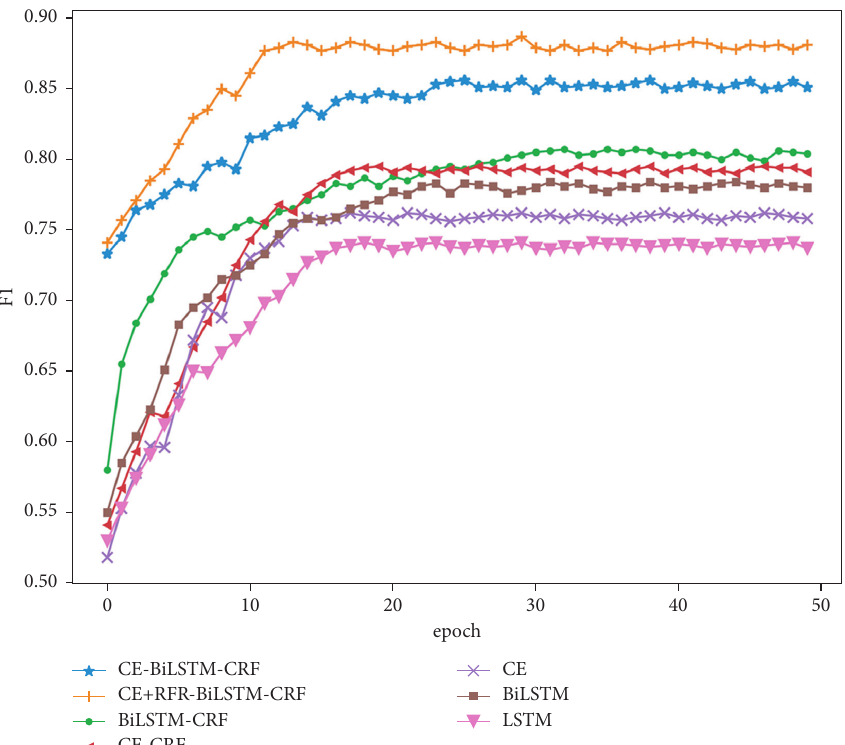
Figure 8: The variation of F 1 values for different modules on the test set.